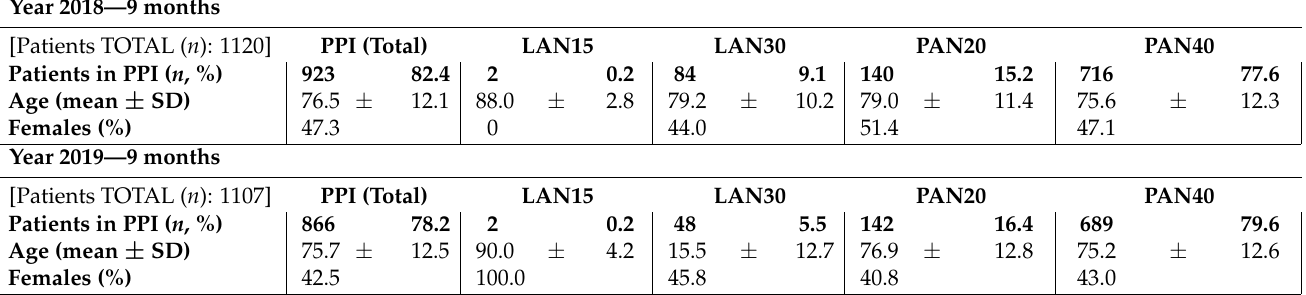
Table 2. Data of Patients treated with